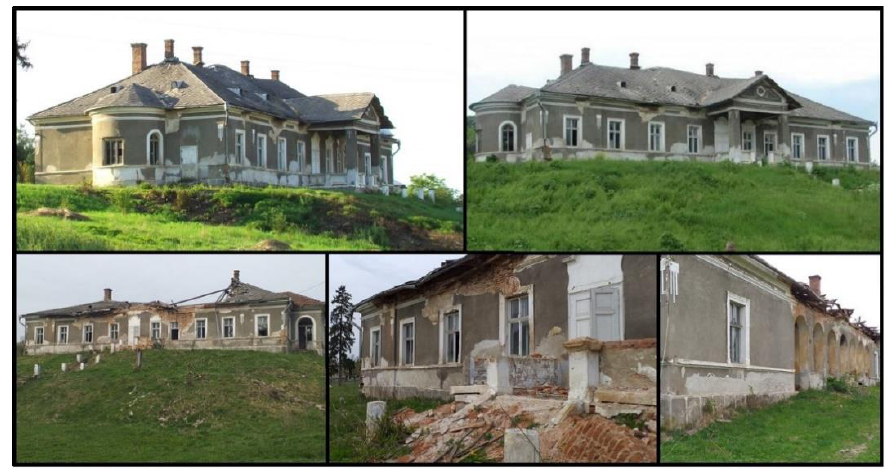
Figure 2. Image from a few years ago ( top ); current state of the mansion ( bottom ).